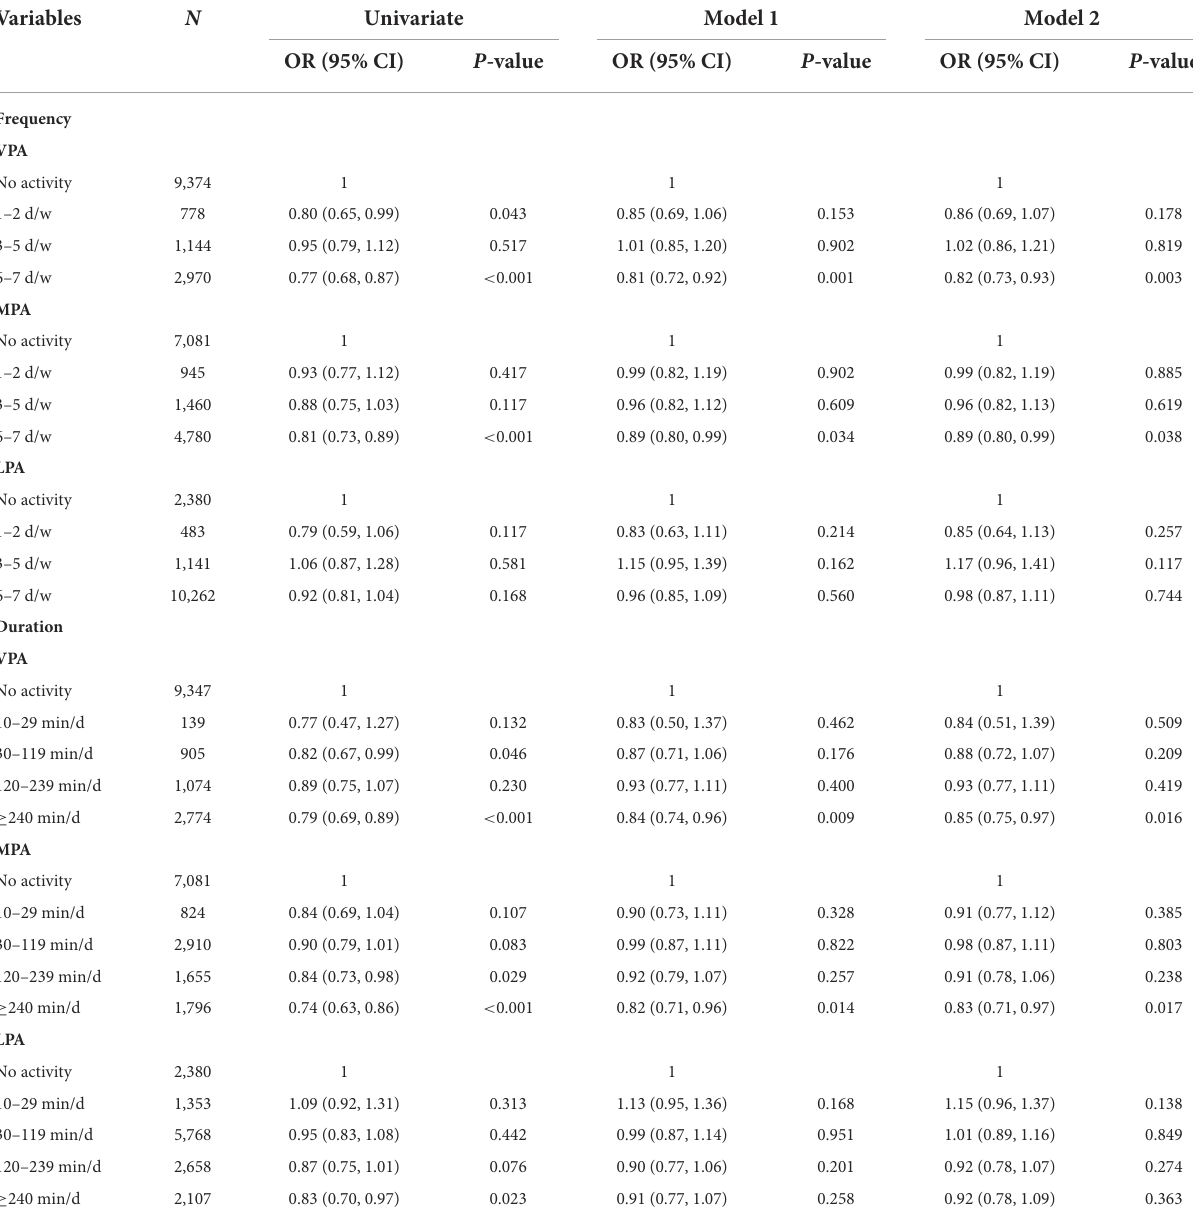
TABLE 3 Logistic regression analysis for the associations between PA and the risk of